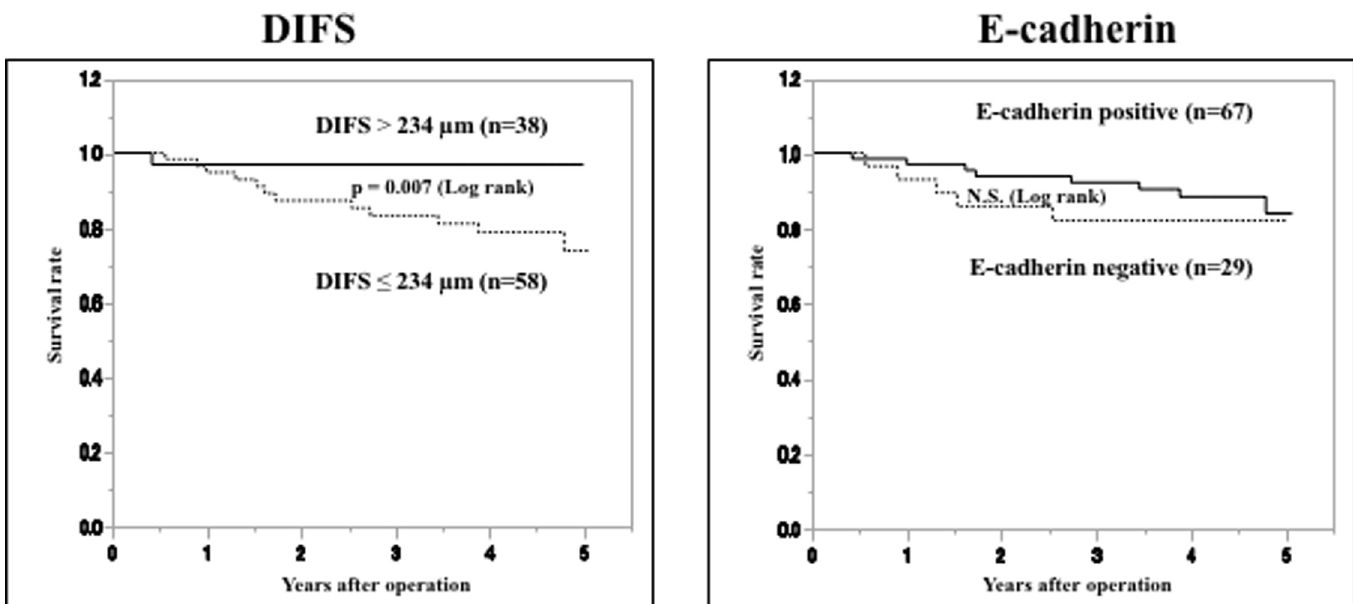
Fig 5. Survival of the patients with gastric cancer. The five-year overall survival of all patients (n = 96) based on the DIFS and on the E-cadherin expression. The Kaplan- Meier survival curve indicates that the five-year overall survival of the patients with a DIFS � 234 μ m was significantly worse than that of the patients with a DIFS > 234 (p = 0.007). E-cadherin expression was not associated with the prognosis.